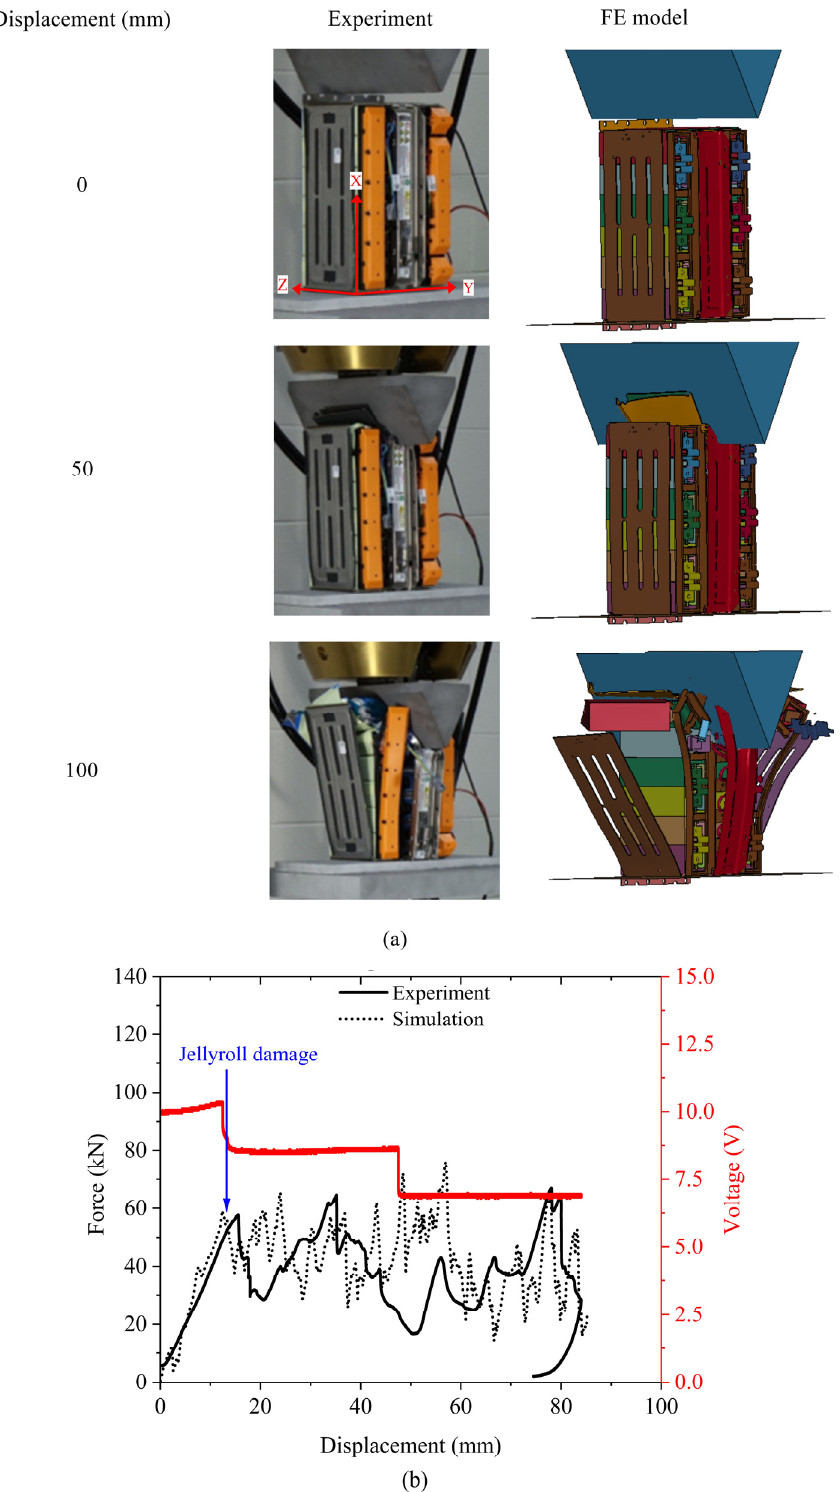
Figure 4. Experimental and FE model simulation for Case 1 (0.05 mm/s quasi-static indentation of battery module along x direction with wedge edge parallel to z direction): ( a ) Module deformations; ( b ) Force-displacement responses (black) and experimental voltage responses (red). The initial peak forces obtained from the experiment and the FE model were 57 kN and 59 kN, respectively (Figure 4b). Experimentally obtained voltage drop (initiation of short-circuit) and peak force occurred at nearly the same displacement indicating that